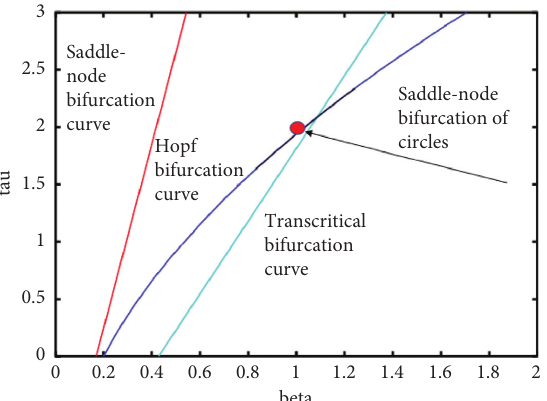
Figure 3: Two-parameter bifurcation diagram of model system (9) in the ( τ , β ) -plane. The fixed parameters are μ � 0 . 18, Λ � 4, p � 0 . 5, κ � 0 . 03, c � 0.02, b � 0.2, δ � 0 . 08, and τ � 2. Red curve denotes saddle-node bifurcation, blue curve denotes Hopf bifurcation, cyan curve denotes transcritical bifurcation, and black curve at (red point) denotes saddle-node bifurcation of cycles.